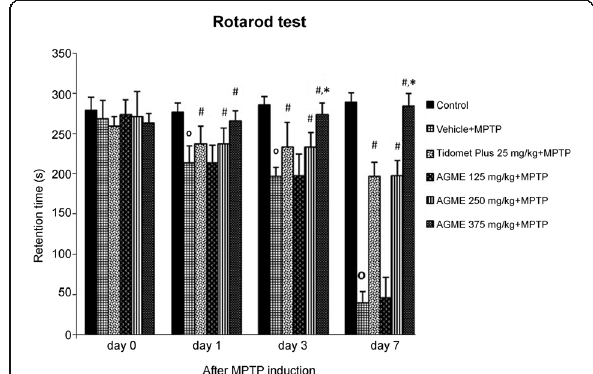
Fig. 5 Effect of AGME on retention time on the rotarod apparatus at 0, 1, 3, and 7 days after MPTP administration. Each data column represents the mean ± SD (n = 8/group, o - p < 0.001 compared with the control group; #- p < 0.05 compared with the vehicle-treated group; * -p < 0.05 compared with the Tidomet Plus-treated